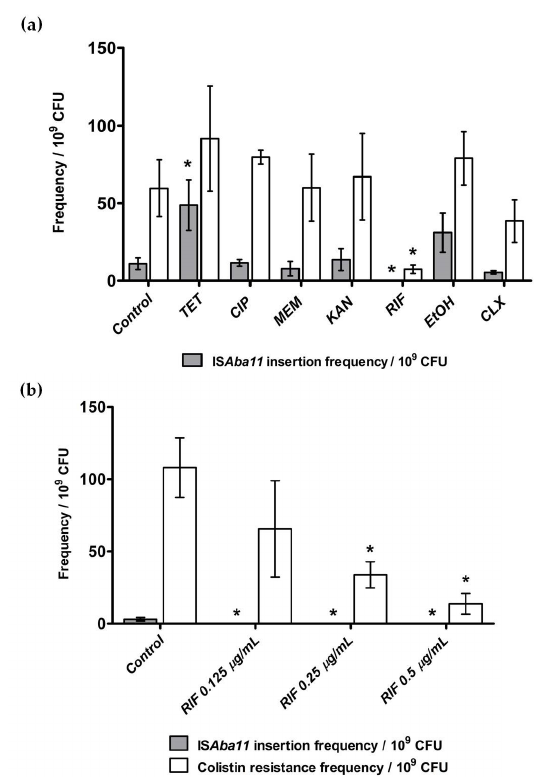
Figure 2. Effect of subinhibitory concentrations on IS Aba 11 insertion frequency in lpxC . ( a ) Frequency of spontaneous emergence of colistin resistance (by any mechanism; white bars) and the emergence of colistin-resistant mutants harboring IS Aba 11 insertions in lpxC (grey bars) after exposure to subinhibitory concentrations of different antibiotics and disinfectants at concentrations of one-quarter of the MIC; TET, tetracycline (0.5 µ g/mL); CIP, ciprofloxacin (1 µ g/mL); MEM, meropenem (0.5 µ g/mL); KAN, kanamycin (2 µ g/mL); RIF, rifampicin (0.5 µ g/mL); EtOH, ethanol (1.5%) and CLX, chlorhexidine (8 mg/mL). ( b ) Spontaneous emergence of colistin resistance (by any mechanism; white bars) and frequency of colistin-resistant mutants harboring IS Aba 11 insertions in lpxC (grey bars) after exposure to the indicated concentrations of rifampicin. Data represented as mean ± standard error of the mean (SEM) of three independent experiments. (*, p < 0.05 compared to untreated controls).